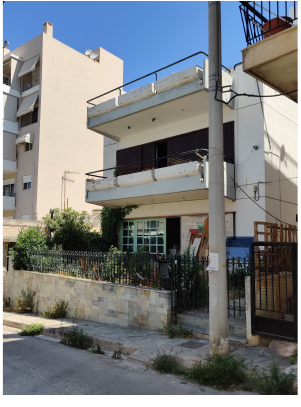
Figure 10. Building 2 street view.